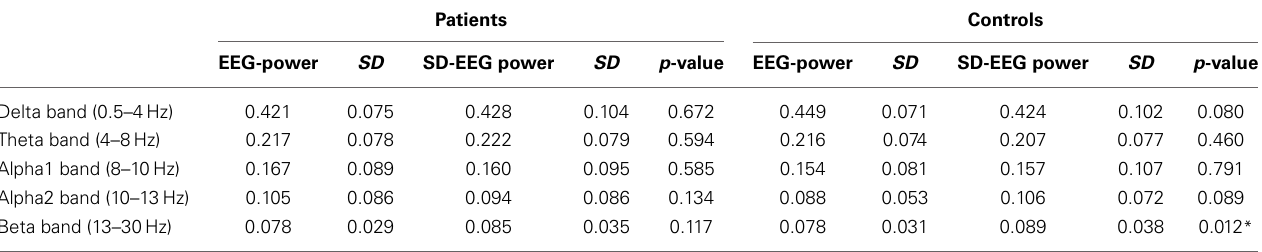
Table 2 | Paired t -test between EEG and SD-EEG recordings (for patients and controls separately) for relative power spectra in five frequency bands.